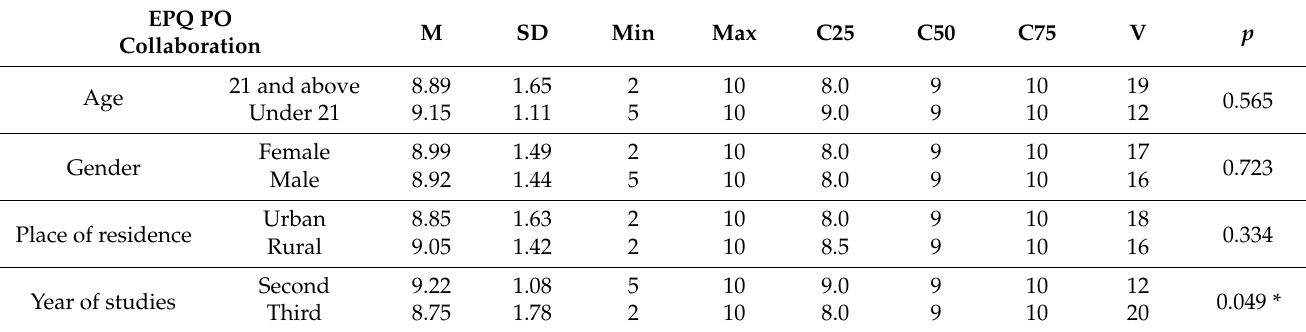
Table 7. Numerical characteristics of results for the EPQ PO questionnaire Collaboration subscale in terms of socio-demographic variables.